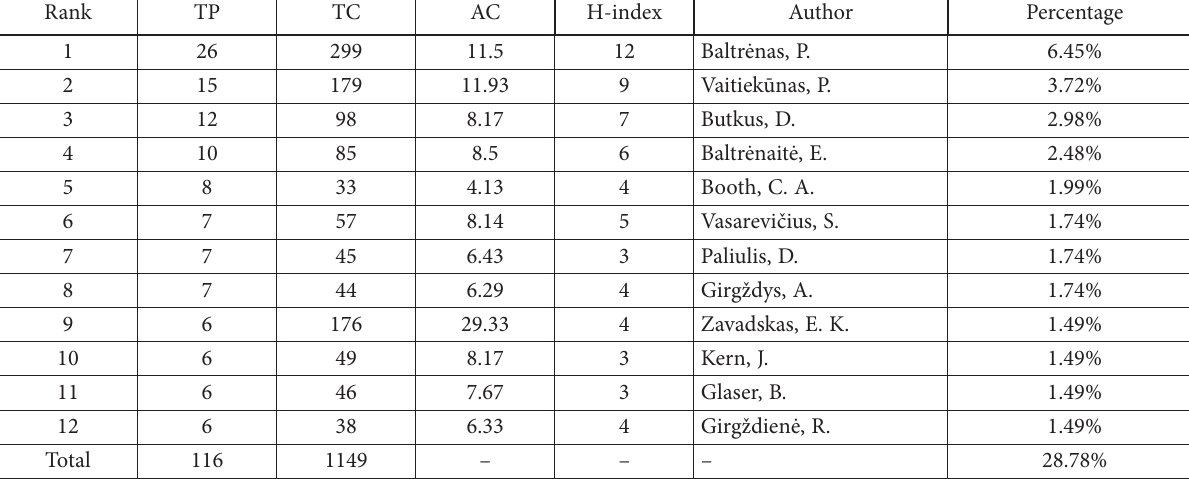
Table 6. The top 12 most influential authors of the JEELM